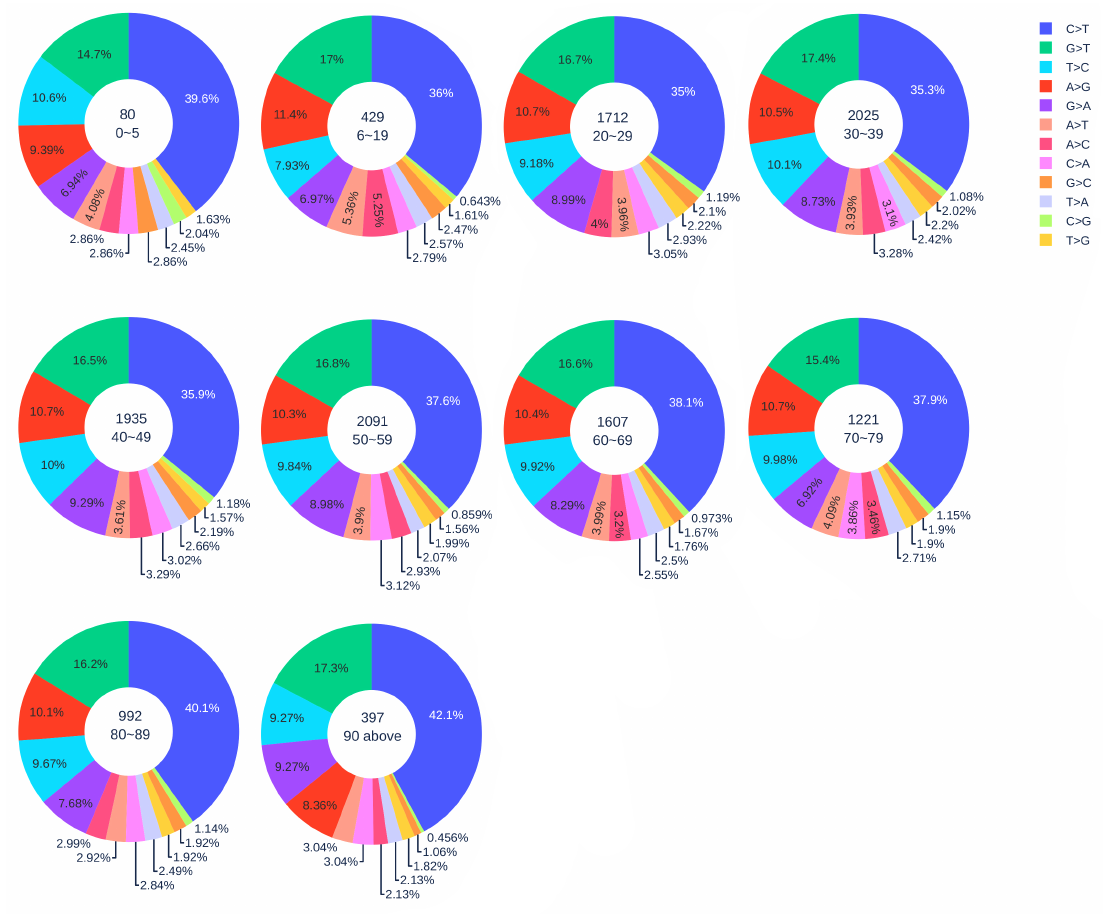
Figure 1. The distribution of 12 SNP types among unique mutations in the SARS-CoV-2 genome isolates from different age groups. The text inside each circle represents the total number of records that have age information for different age